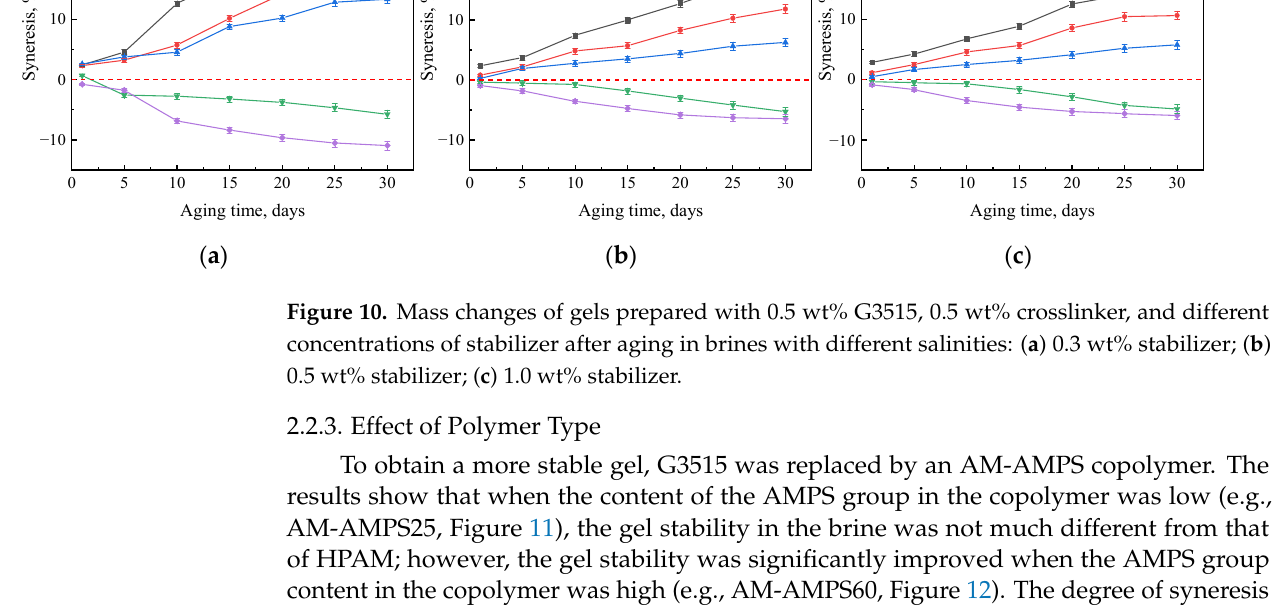
Figure 9. Mass changes of different gels after aging in brines with different salinities for different times: ( a ) Gels consist of 0.5 wt% G3515, 0.5 wt% crosslinker, and 0.3% stabilizer; ( b ) Gels consist of 0.5 wt% G3515, 1.0 wt% crosslinker, and 0.3% stabilizer; ( c ) Gels consist of 0.75 wt% G3515, 0.5 wt% crosslinker, and 0.3% stabilizer; ( d ) Gels consist of 0.75 wt% G3515, 1.0 wt% crosslinker, and 0.3% stabilizer.